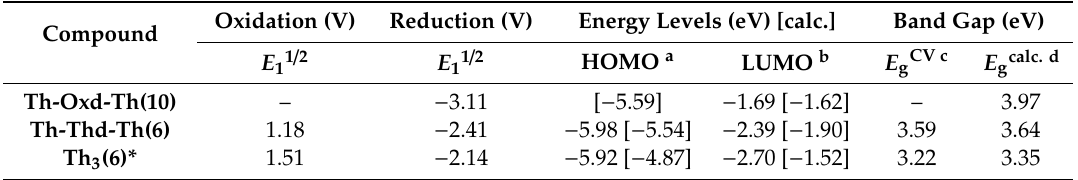
Table 3. Summary of the electrochemical properties of Th-Oxd-Th(10) and Th-Thd-Th(6) along with literature data for Th 3 (6)